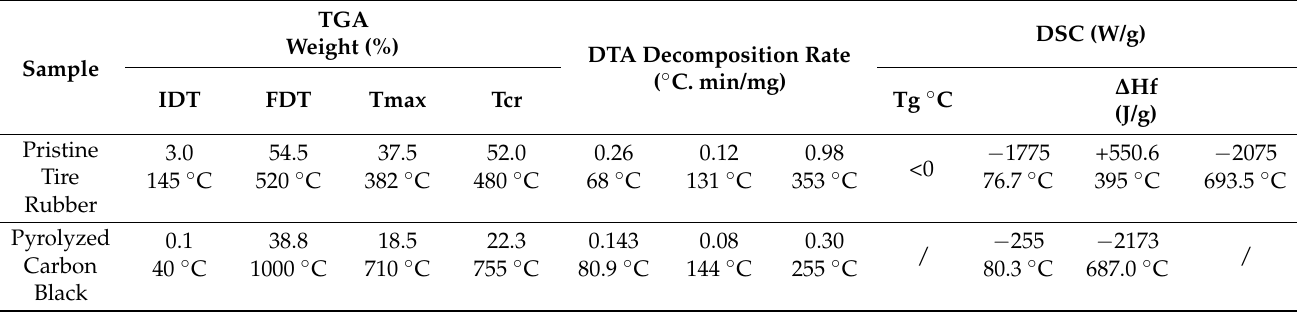
Table 2. TGA, DTA and DSC thermal analyses of pristine tire rubber and pyrolyzed carbon black recovered from scrap